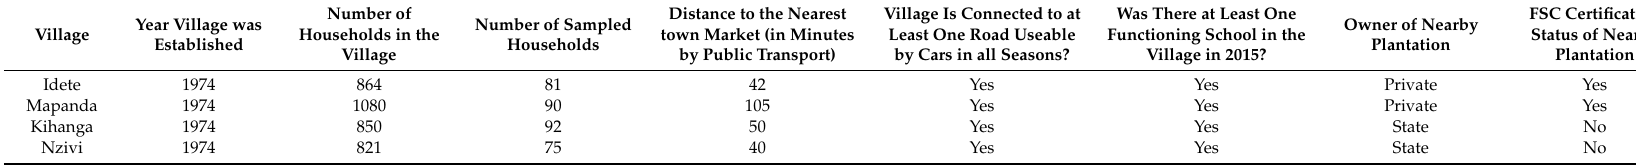
Table 1. Characteristics of Study Villages.